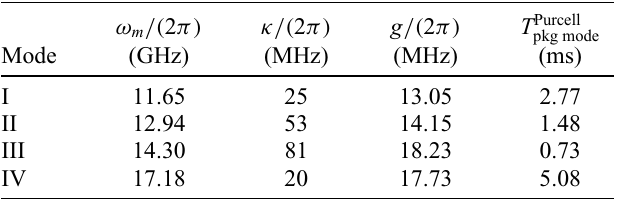
20 GHz. The table contains the mode’s resonance frequency /( 2 π) , the mode linewidth κ/( 2 π) , coupling strength to the ω m qubit g /( 2 π) as extrapolated using Eq. (5), and the